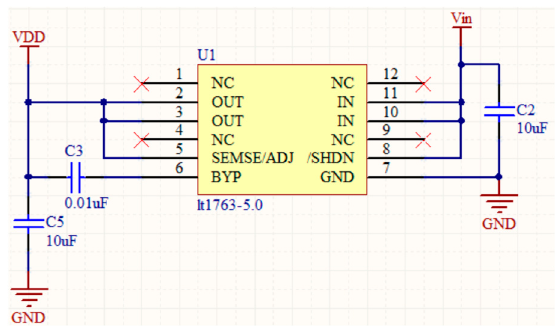
Figure 4. Circuit diagram of the regulator.